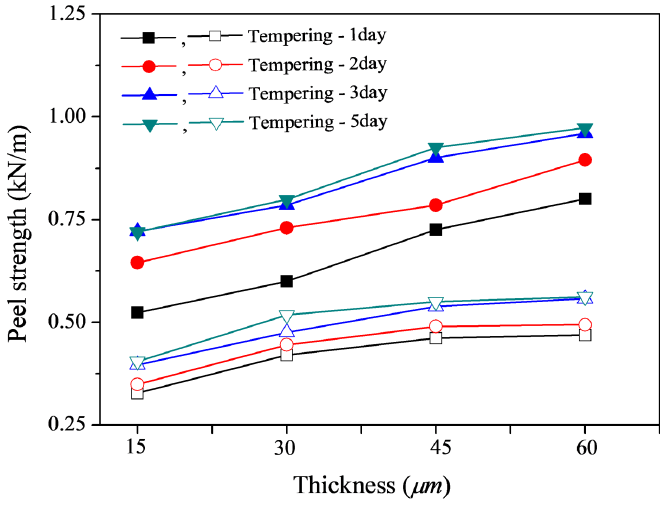
Figure 11. Effects of adhesive thickness and tempering time on the adhesive strength of CPP/EPDM-B-15/Al foil (open symbol) and CPP/EPDM-B-15/APTES-treated Al foil (filled symbol).